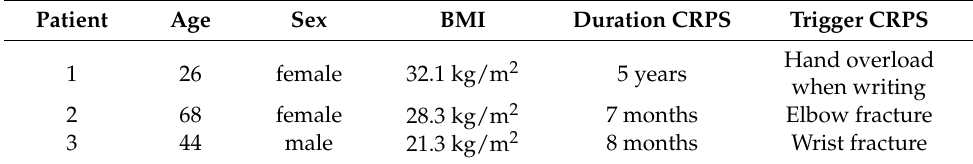
Table 1. Demographics of patients.